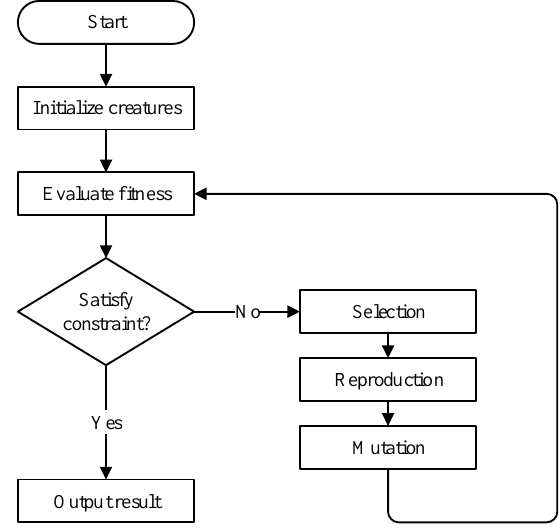
Figure 1. The flowchart of conventional GA.